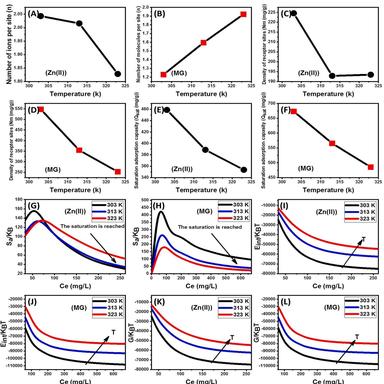
Changes in the numbers of adsorbed (A) Zn2+ ions and (B) malachite green (MG) dye molecules at each site of Mg-doped hydroxyapatite nanofibers (Mg. HAPNFs). Densities of occupied active sites of Mg.HAPNFs for the adsorption of (C) Zn2+ ions and (D) MG dye. Adsorption capacities of Mg.HAPNFs for (E) Zn2+ ions and (F) MG dye at different saturation states. Entropy (Sa) values for the adsorption of (G) Zn2+ ions and (H) MG dye onto Mg.HAPNFs. Internal energy (Eint) values for the adsorption of (I) Zn2+ ions an